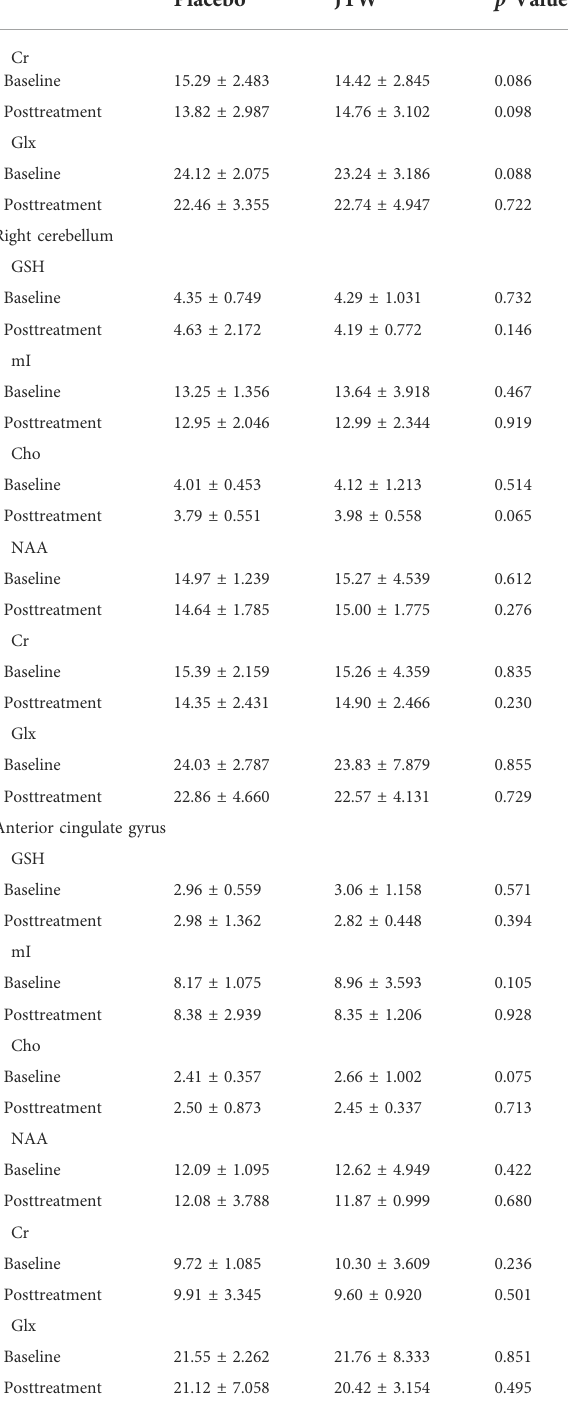
TABLE 5 Blood tests in the participants at baseline and posttreatment in the JTW and placebo groups. Placebo JTW